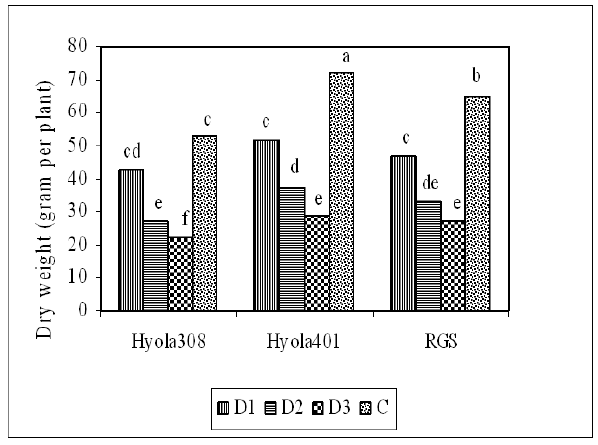
Fig. 1. Interaction of cultivars and water stress on shoot dry mat-